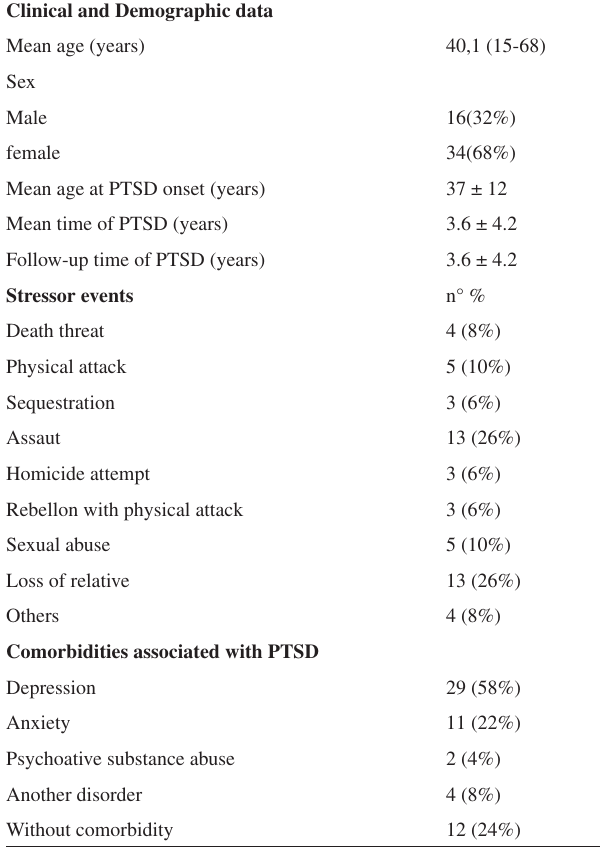
Table 1 - The most frequent events related to PTSD